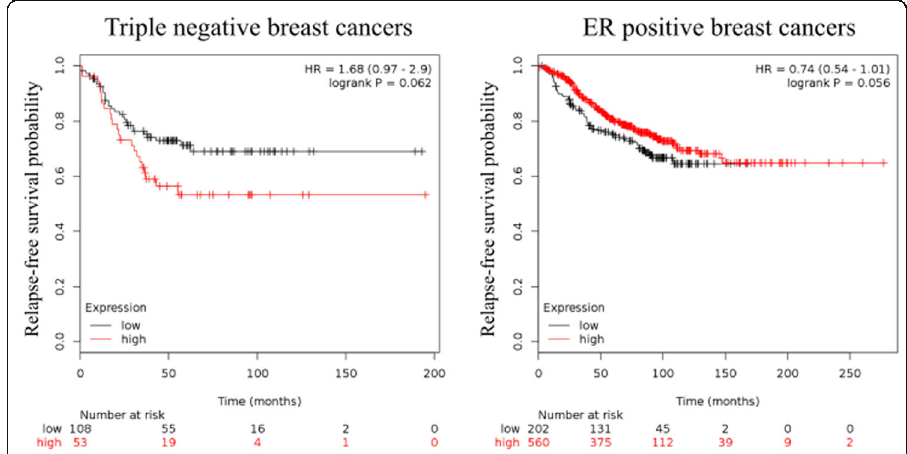
Fig. 5 Kaplan-Meier plot of STAT3 mRNA levels in triple negative and ER + breast cancers. Affymetrix ID for STAT3 was 225289_at. Relapse-free survival of patients was analysed. JetSet best probe set and auto select best cut-off were used for analysis